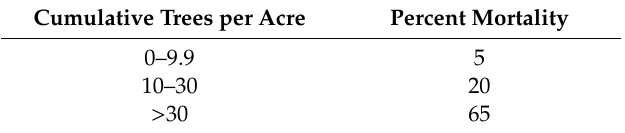
Table2. ConversionfactorsfromEganetal.